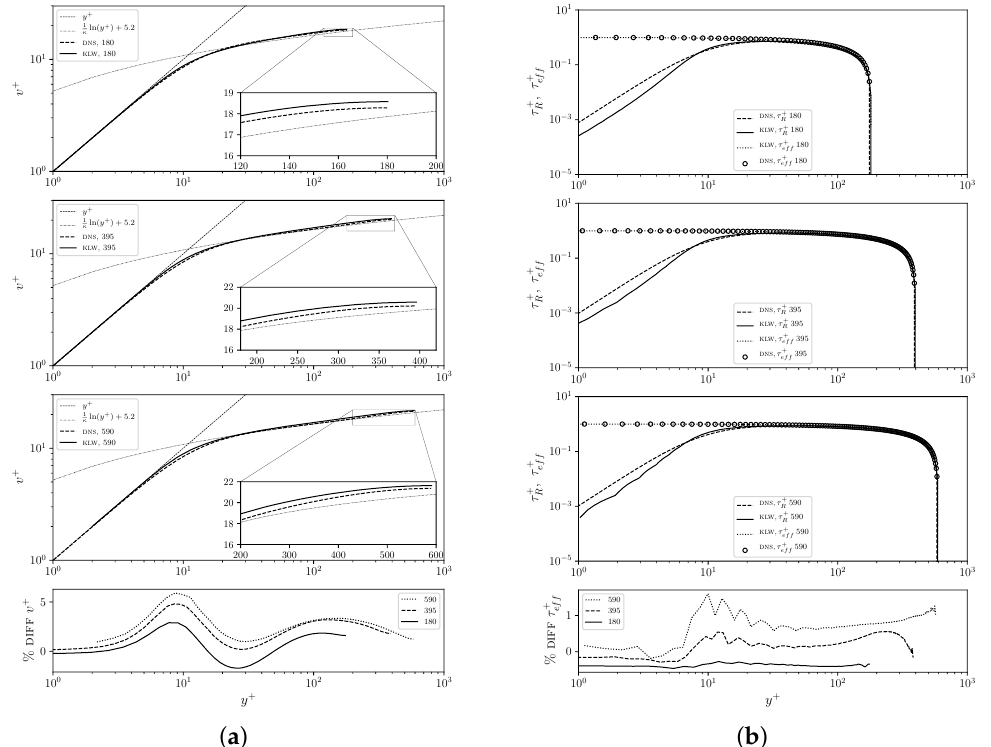
Figure 1. Two-dimensional channel tests ( Pr = 0.01). Non-dimensional mean axial velocity v + profiles ( a ) and non-dimensional Reynolds stresses ( b ) as a function of the non-dimensional wall distance y + . Results obtained with KLW model are compared with DNS data [10]. The quantitative analysis (plots on bottom) show the percentage difference computed between the KLW and DNS results for v + and τ + ef f